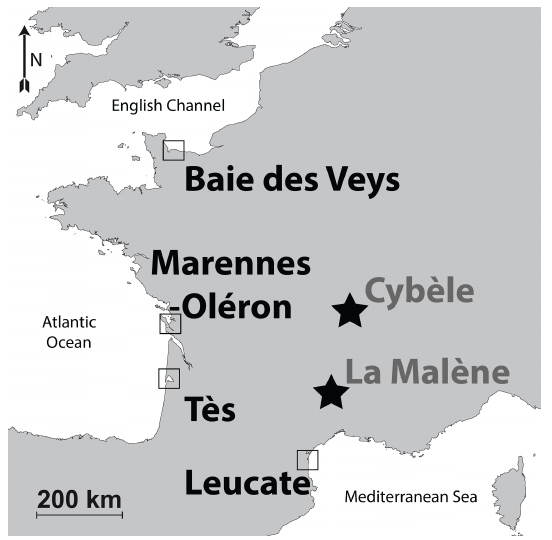
Figure 1. Map of the localities of modern (squares) and archaeo- logical (stars) specimens. The coordinates of the modern sites are indicated in Table